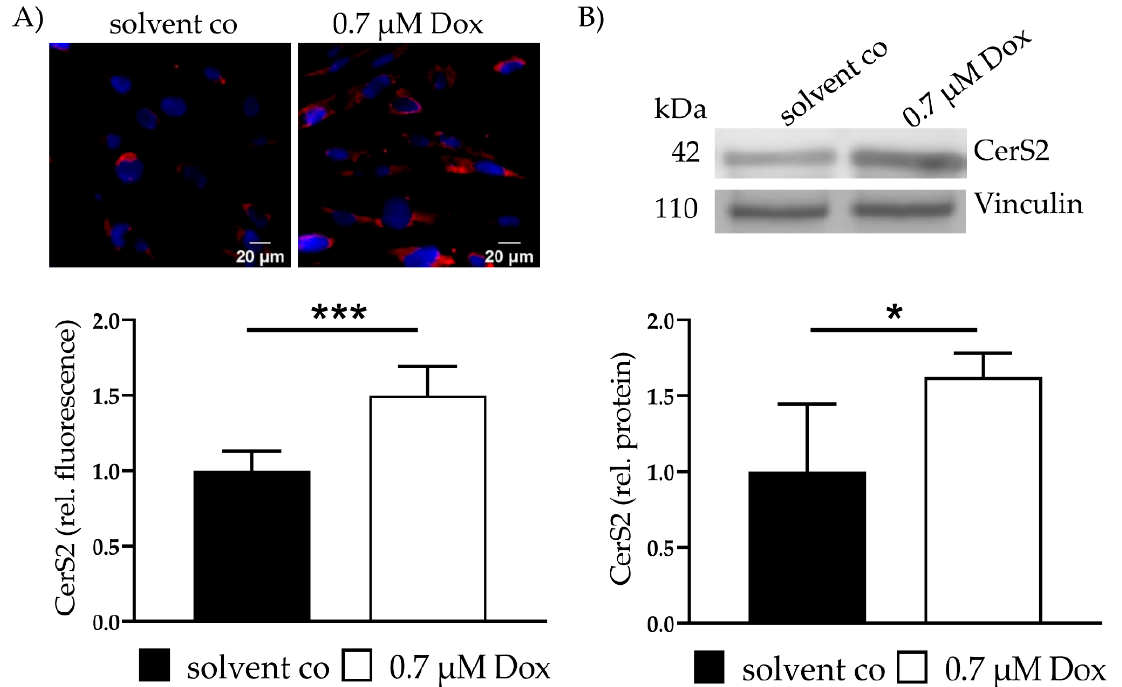
Figure 1. CerS2 and Ceramides—CerS2 protein expression and Ceramide level after Dox treatment and FuB preincubation. ( A ) CerS2 was stained with IF (red). Nucleus was stained blue. Intensity was determined with cLSM. Illustrated are two representative pictures. ( B ) CerS2 expression was assessed with WB with the same antibody. Illustrated is one representative blot. Depicted are mean values and standard deviation of minimum 3 biological replicates. Significances were calculated for all with a t -test (* p ≤ 0.05, *** p ≤ 0.001). solvent co = solvent control. Dox = Doxorubicin, FuB = Fumonisin B1. Table 1. ceramide levels in Dox treated and FuB pretreated fibroblasts.